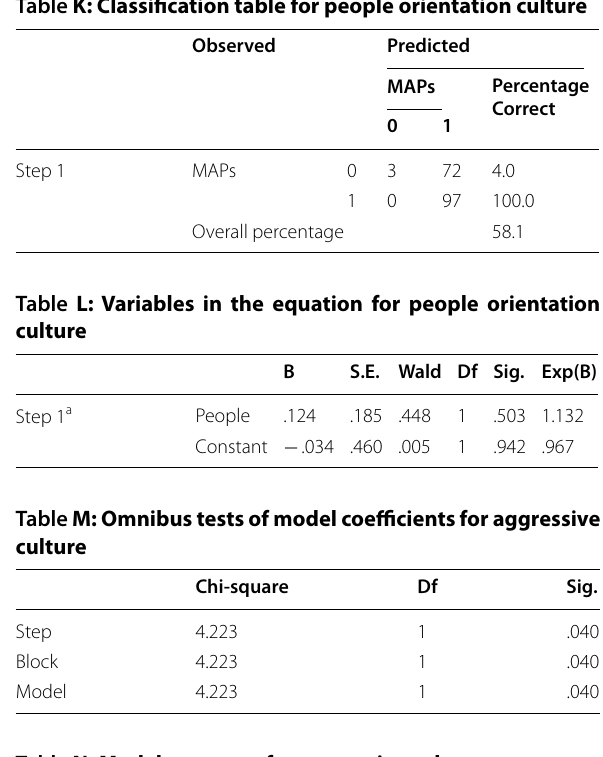
Table N: Model summary for aggressive culture 2 Log-likelihood Cox and Snell R-square Nagelkerke R-square −